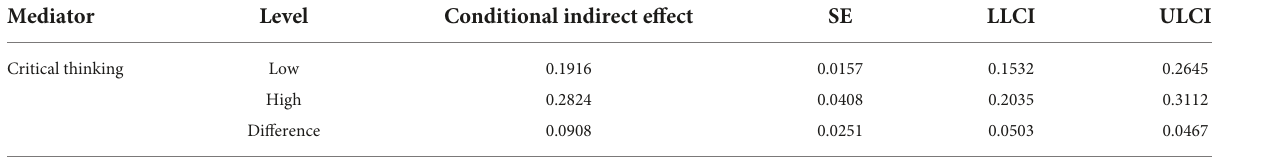
TABLE 4 Moderated mediated results for PI and TS across levels of